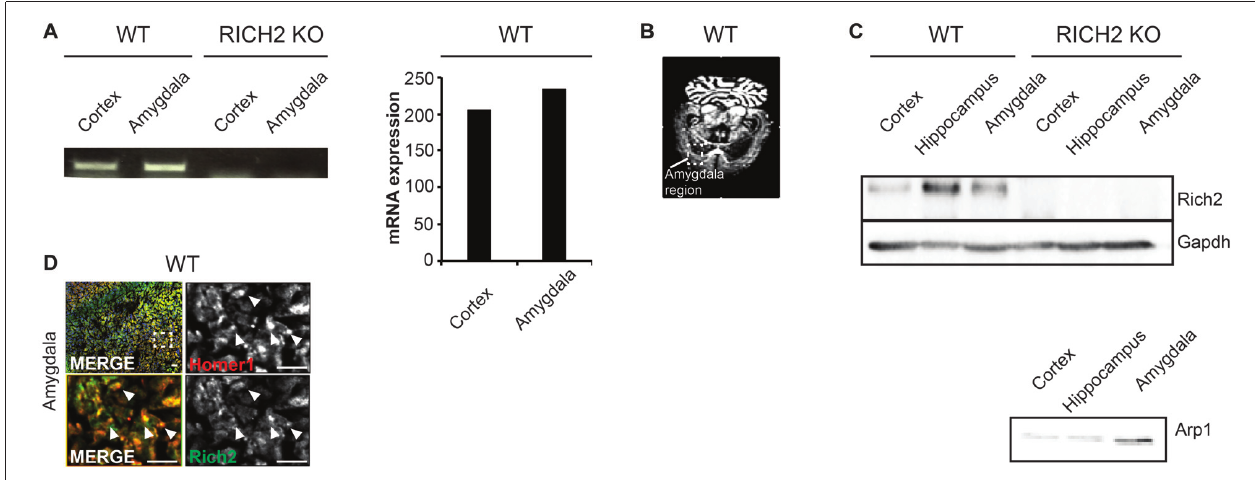
FIGURE 1 | RICH2 is expressed at glutamatergic synapses in the amygdala. (A) Expression of Rich2 was detected on mRNA level using a PCR approach in amygdala using lysate from wild type (WT) mice. Cortex lysate was used as control as expression of Rich2 has been reported in cortex previously. The expression levels of Rich2 in amygdala were slightly higher compared to cortex. The primers used for amplification of Rich2 were placed in a region deleted in the genome of RICH2 Knockout (KO) mice. Absence of Rich2 expression in amygdala of RICH2 KO mice was confirmed. (B) In situ hybridization confirms Rich2 expression in the amygdala in adult WT animals. (C) RICH2 protein was not detected in RICH2 KO mice, but in amygdala of WT mice, and hippocampus and cortex as reported previously. ARP1 is a protein enriched in amygdala and was used as control to ensure proper preparation of amygdala tissue. (D) Immunocytochemistry performed on brain sections of WT mice reveals RICH2 signals co-localizing with HOMER1, a marker for excitatory postsynapses, in the amygdala. Top left: overview indicating magnified area in bottom left and right images. Arrows indicate clearly co-localizing signals (scale bar = 20 µ m).